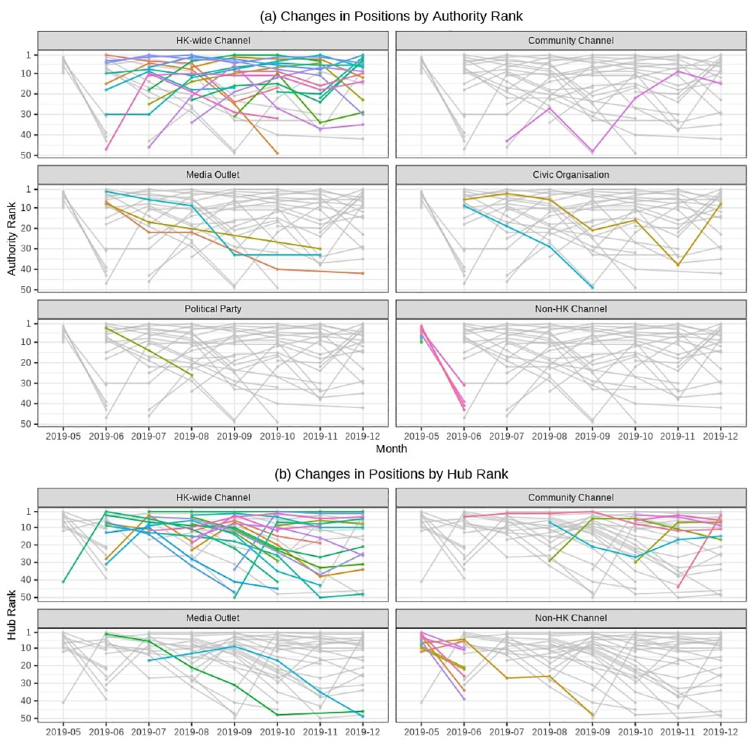
Fig 8. Changes in the channel/group positions by authority and hub score by month. To make the figure easier to interpret for those not familiar with individual Telegram channels and groups as well as to protect the identities of the most influential sources in light of the National Security Law, we report source types instead of particular source names. The classification of the types was done manually by one of the authors who is fluent in Cantonese and Mandarin and is highly familiar with the local context due to the focus of their